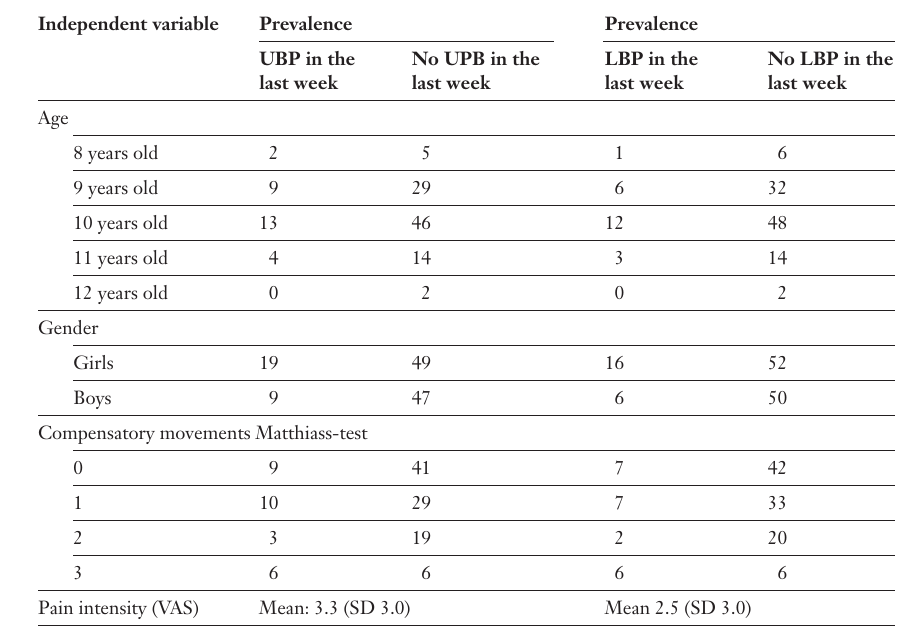
Table 2 Frequencies of self-reported pain in different subgroups